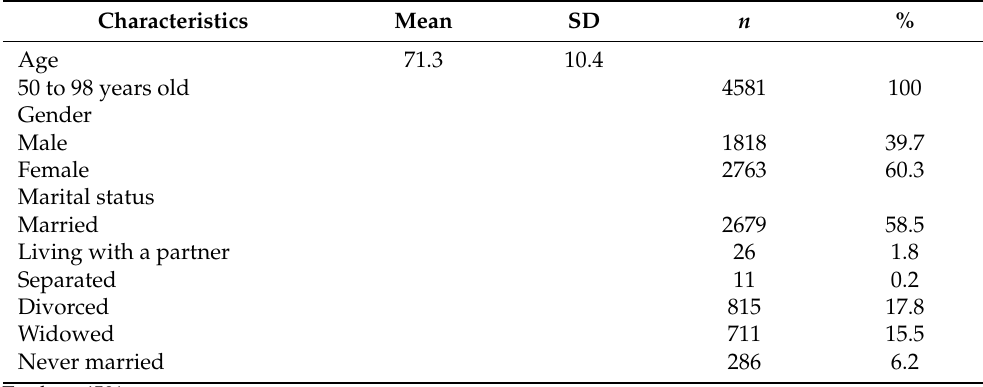
Table 1. Characteristics of the study